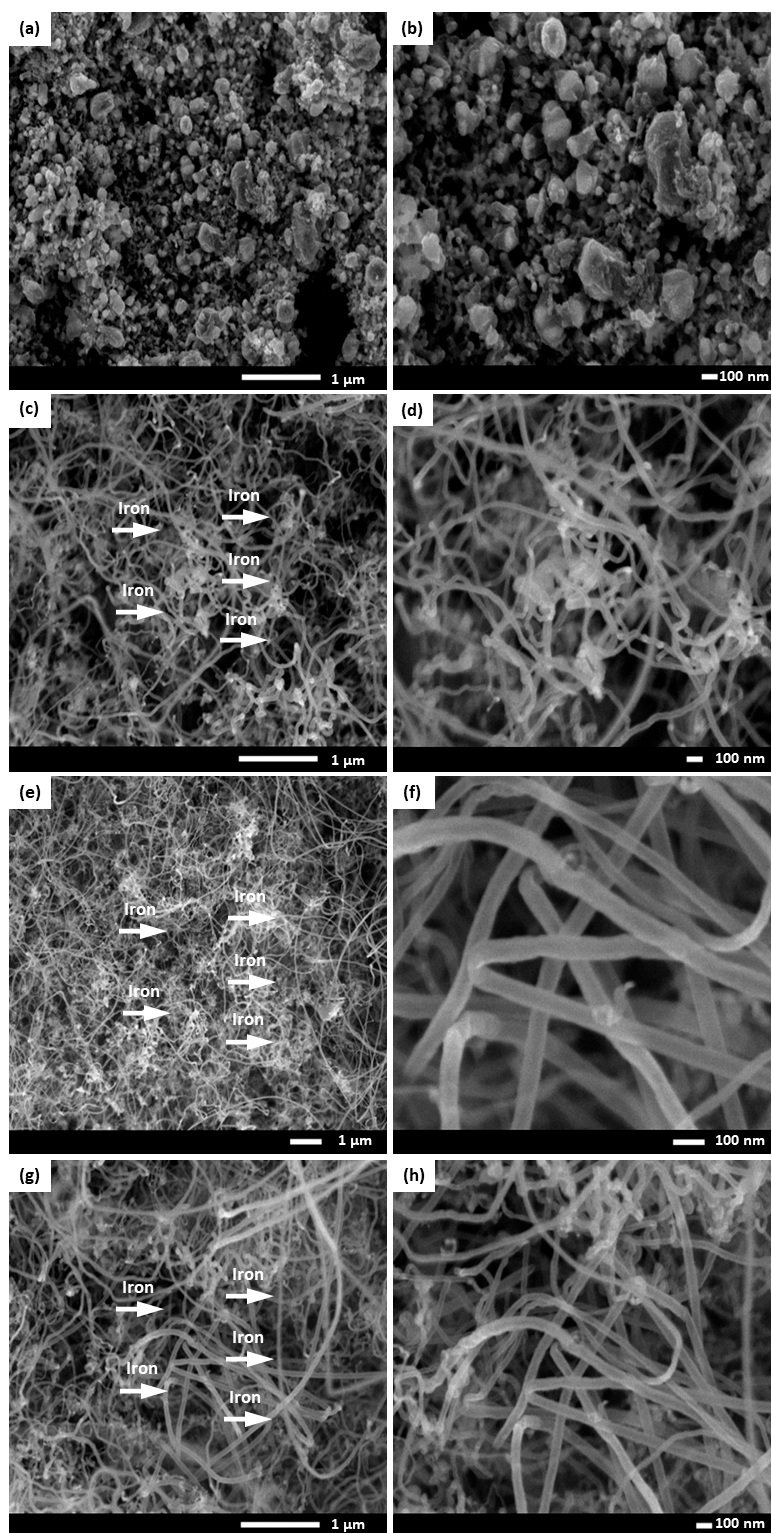
Figure 4. FE-SEM images of the carbon nanofiber-coated monoliths (CNFCMs) synthesized at various temperatures ( a and b ) 600 ◦ C, ( c and d ) 700 ◦ C, ( e and f ) 800 ◦ C, ( g and h ) 900 ◦ C. Red arrow: iron